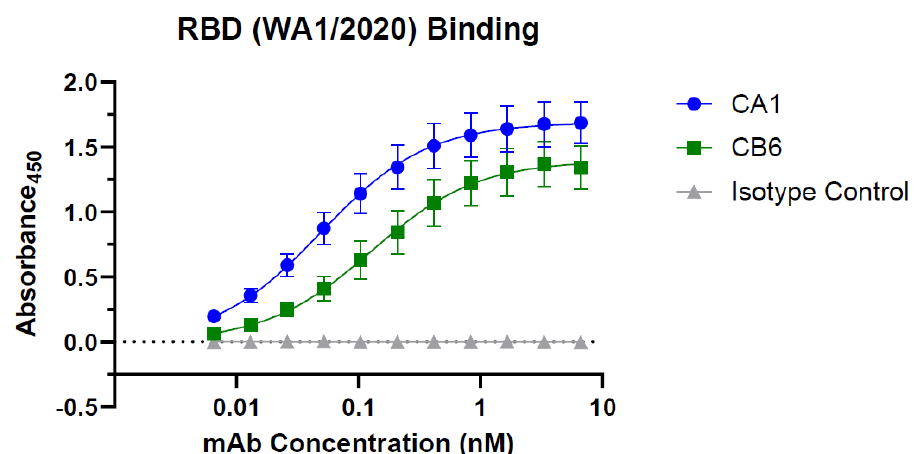
Figure 4. Antigen-specific recognition of plant-made CA1 and CB6. Plant-made CA1 and CB6 were serially diluted and incubated with SARS-CoV-2 RBD (WA1/2020) coated on plates. The specific binding of CA1 or CB6 with RBD was detected by an HRP-conjugated secondary antibody. A plant-produced mAb against WNV (E16) was used as the IgG isotype negative control. The absorbance 450 values presented are mean ± SEM from three independent experiments.